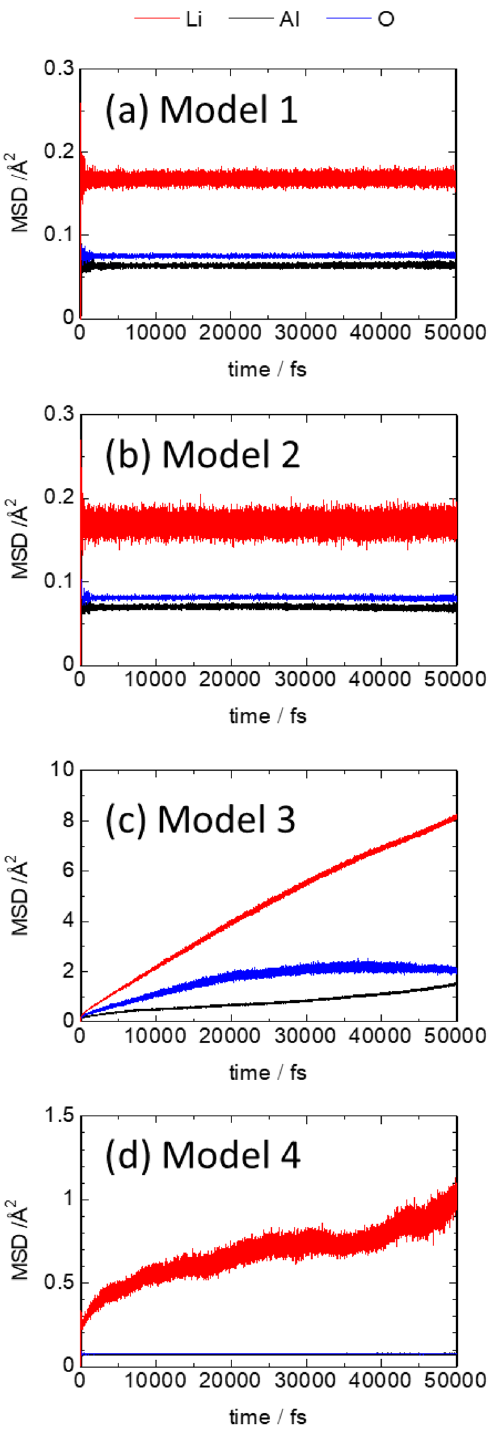
Figure 3. Mean square displacement (MSD) plots of Li, Al, and O obtained by first-principles molecular dynamics (FPMD) calculations for Models 1–4 at 1273 K. ( a ) Model 1, ( b ) Model 2, ( c ) Model 3, and ( d ) Model